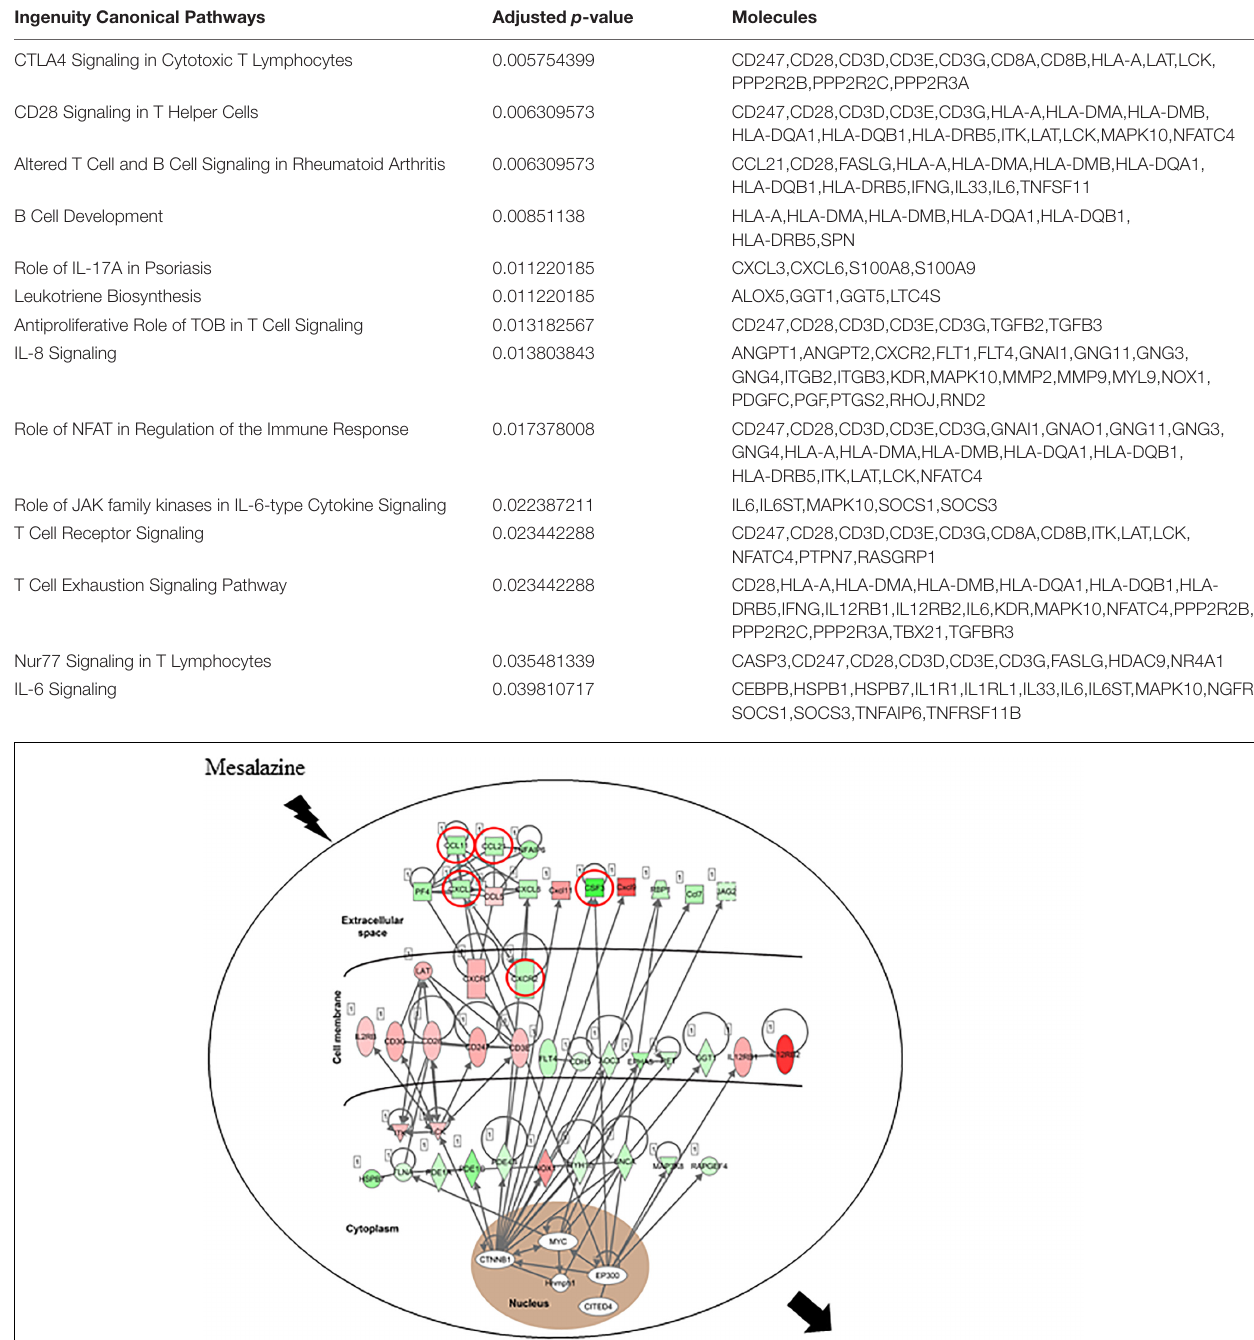
Frontiers in Genetics |